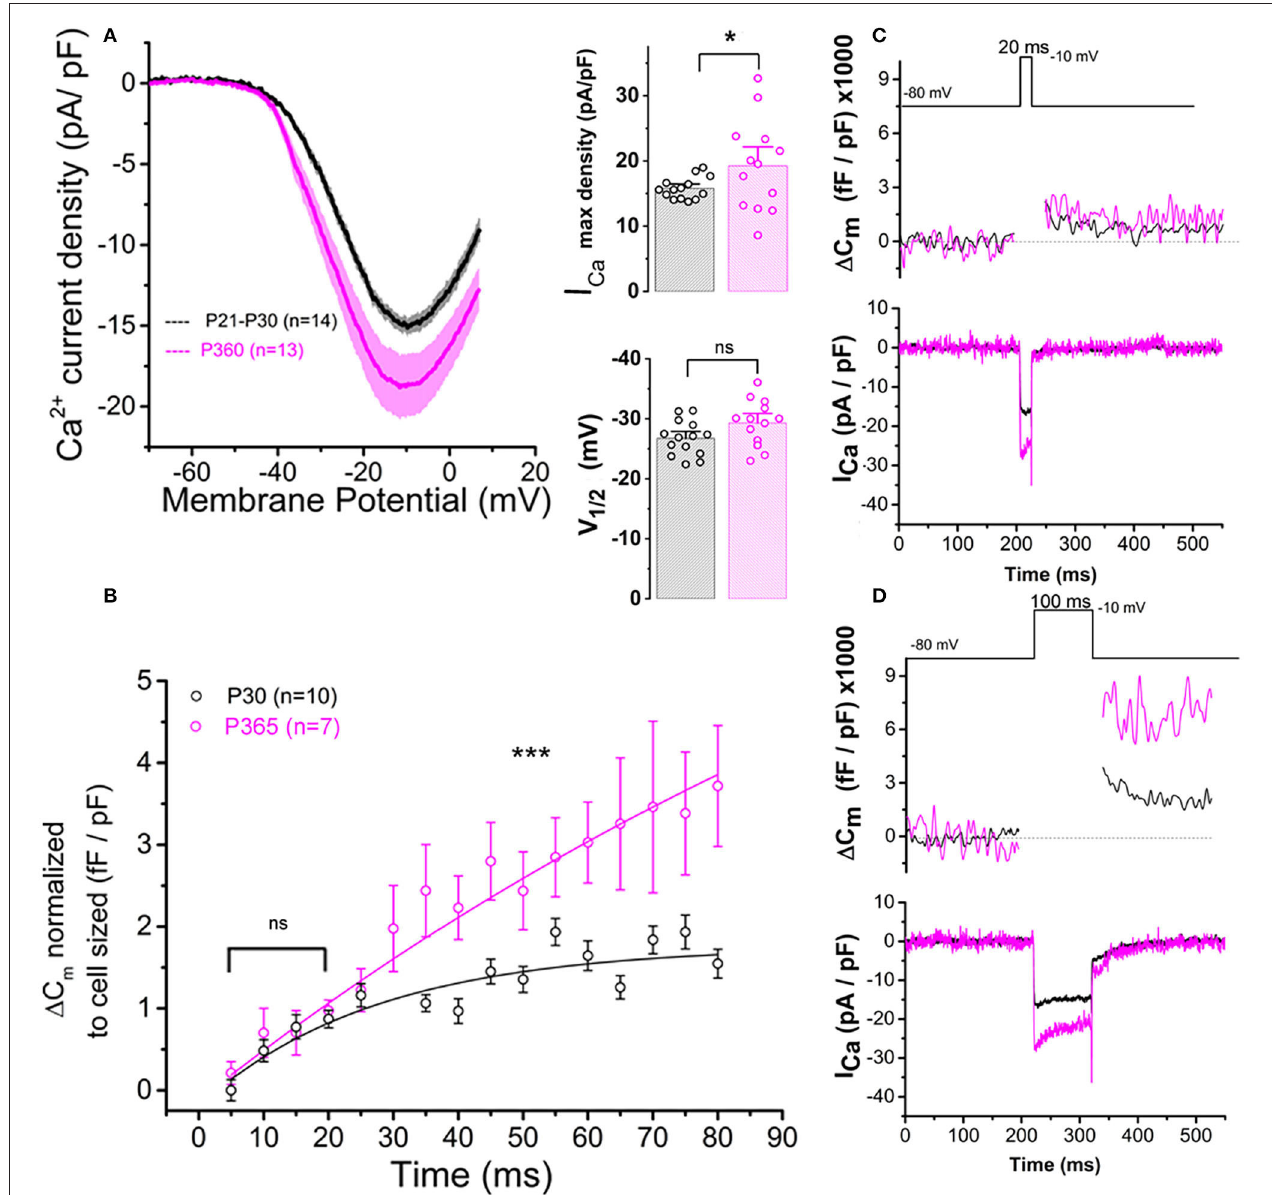
FIGURE 7 | Ca 2 + currents and exocytosis are exacerbated in IHCs from aged C57BL6/J mice. (A) Ca 2 + current density of old P365 IHCs (pink) was larger as compared to young mature P21 IHCs (black). IHCs were subjected to a voltage ramp stimulation from − 90 to + 30mV in 120ms, giving a slope change in voltage of 1 mV/ms. Comparative I Ca maximum density measured at − 10mV indicated a significant increase in P360 IHCs (unpaired two-sample t -test, p = 0.03) while the half-max voltage activation (V 1 / 2 ) of the Ca 2 + currents remained unchanged (unpaired t -test, p = 0.06). (B) Kinetics of exocytosis were evoked by a voltage-steps from − 80 to − 10mV with increasing duration from 5 to 80ms. Note that brief stimulations below 25ms, a time-frame addressing the release of the Readily Releasable Pool of vesicles, the exocytotic response (normalized to cell size) was similar in P30 and P360 IHCs ( p = 0.2; two-way ANOVA). Longer stimulations, above 30ms, which probed the activation of the secondarily releasable pool of vesicles, showed a significant increase in exocytosis (two-way ANOVA; p = 2.3 E − 8), indicating that old IHCs were more likely to sustain high rates of vesicular release. (C,D) Representative examples of 1 C m and I Ca recordings from P30 and P365 IHCs during a 20ms and a 100ms voltage-step stimulation from − 80 to − 10mV. The number of IHCs, indicated in graph, were obtained from five mice at P365 and six mice at P30. Asterisks indicate statistical difference with * p < 0.05 and *** p < 0.001.